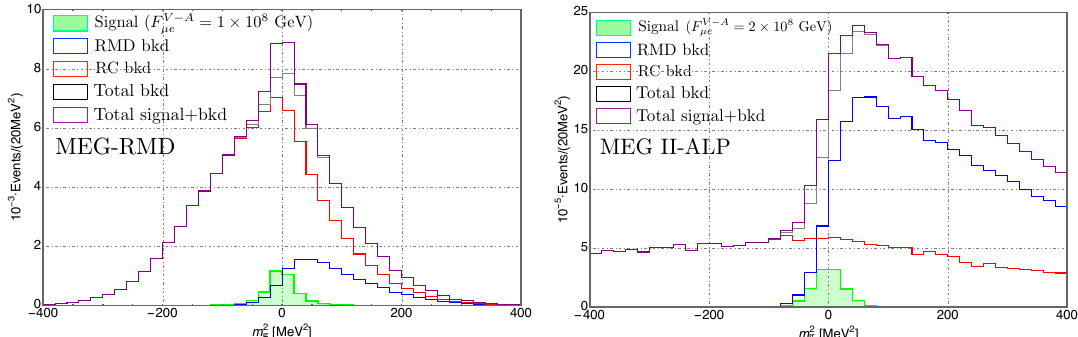
Figure 3 . Missing invariant mass distribution of signal and backgrounds after kinematic selection, detector efficiency and acceptance and resolution effects are taken into account. The ALP is fixed to m a = 10 − 4 MeV, which is effectively massless within the m distribution at MEG. Right: missing invariant mass distribution with the MEG II-ALP data taking strategy proposed in section